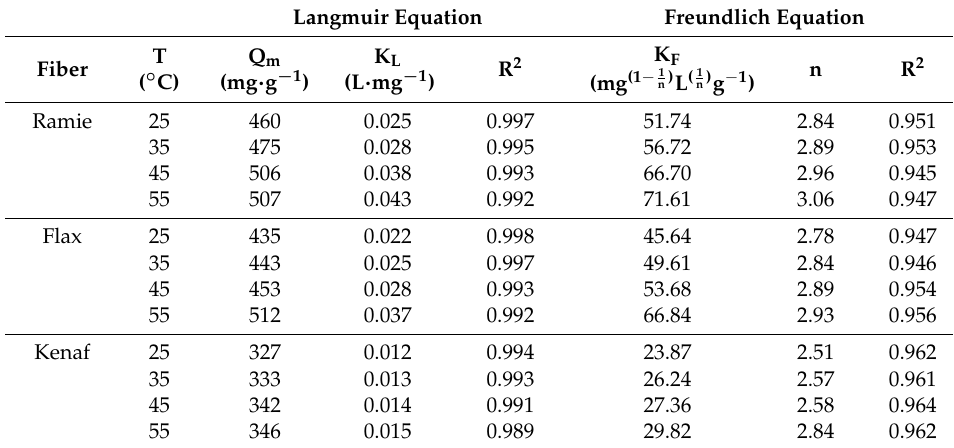
Table 2. Equilibrium parameters for the adsorption of BY37 at 25, 35, 45, and 55 ◦ C onto ramie, flax, and kenaf fibers. Langmuir